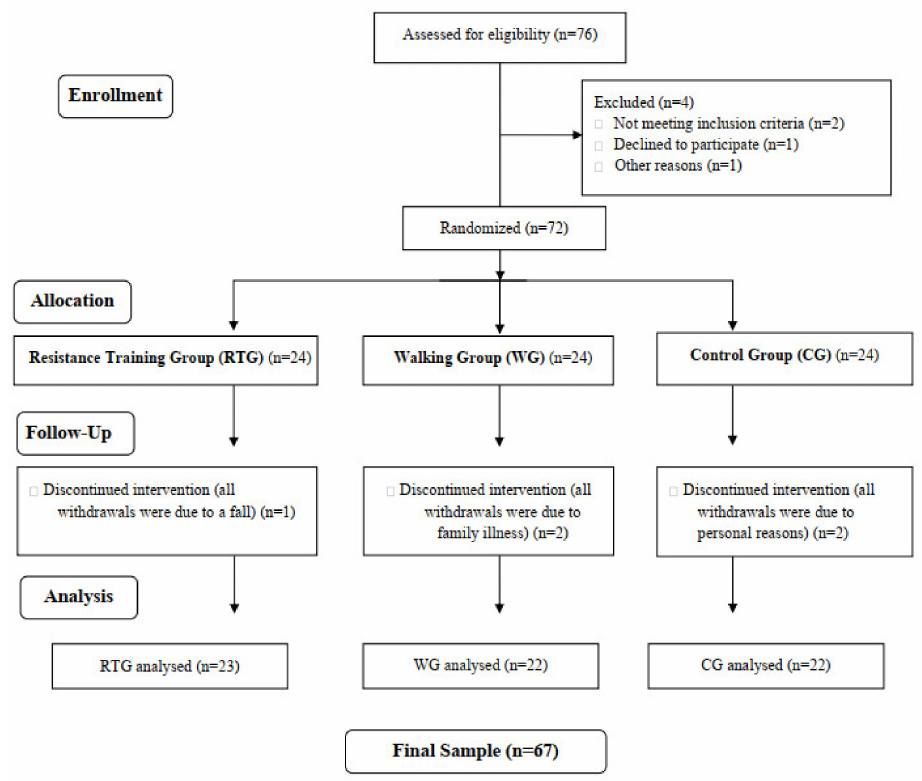
Figure 1. Consort 2010 flow